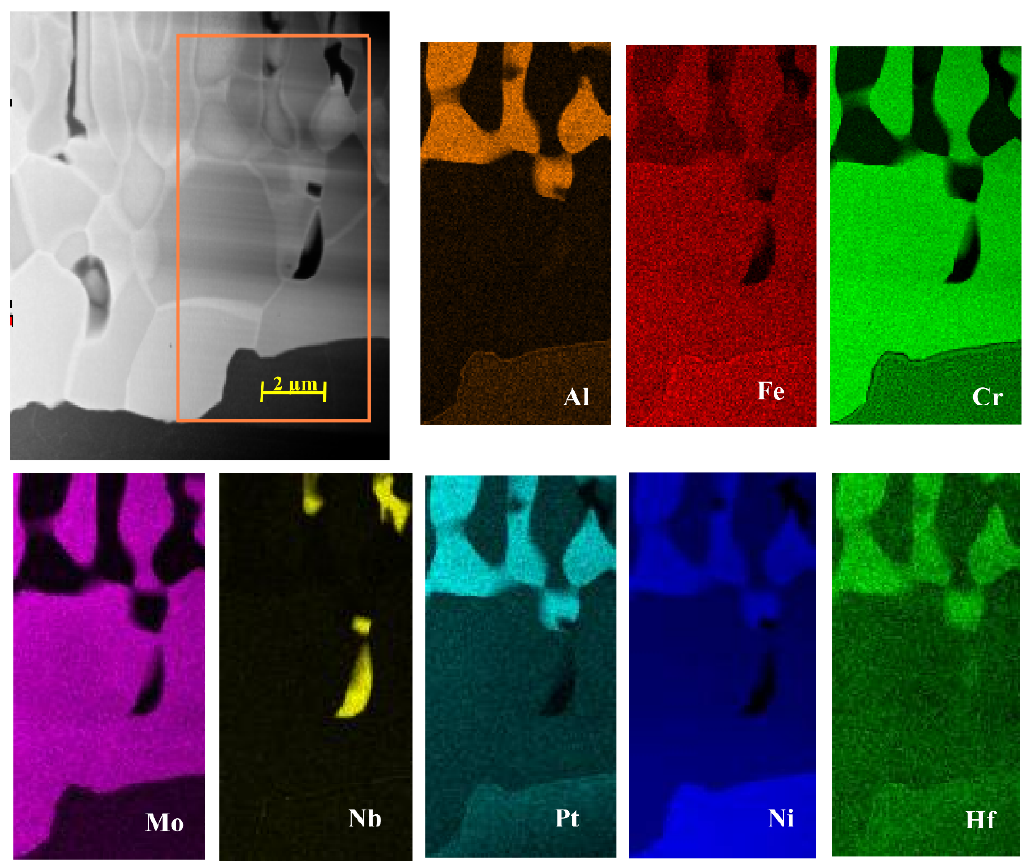
Figure 5. Scanning Transmission Electron Microscopy (STEM) high-angle annular dark field (HAADF) image of the interdiffusion layer with corresponding maps presenting distribution of Al, Cr, Fe, Hf, Mo, Nb, Ni, Pt. Materials 2018 , 11 , x FOR PEER REVIEW